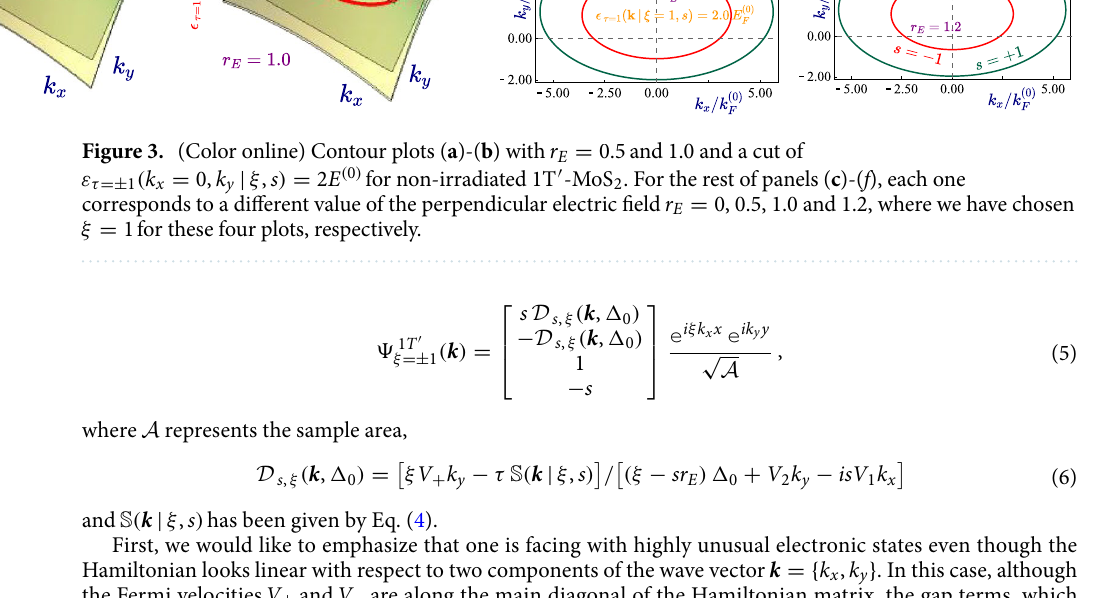
1 state is closed for r =